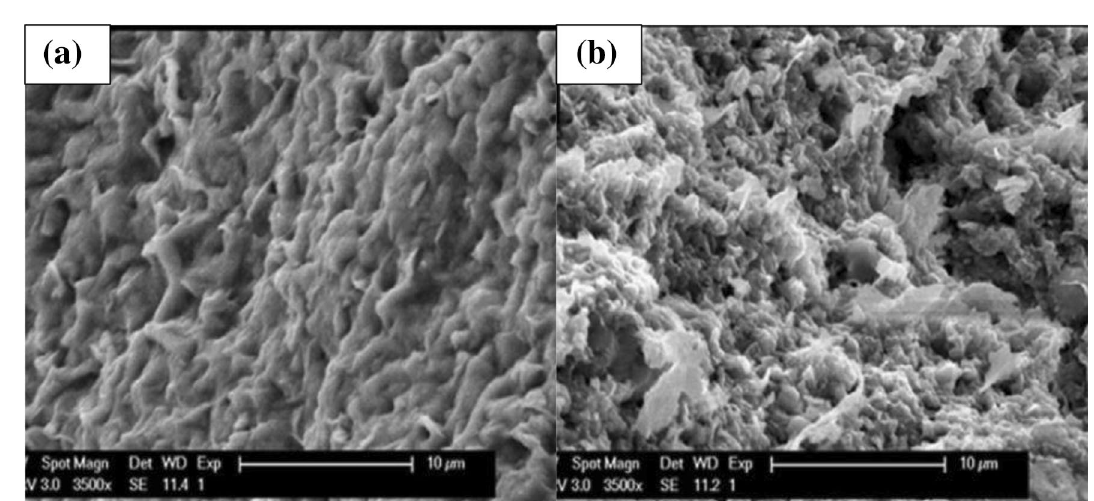
Fig. 6 SEM image of mud cake; a in the absence of Fe